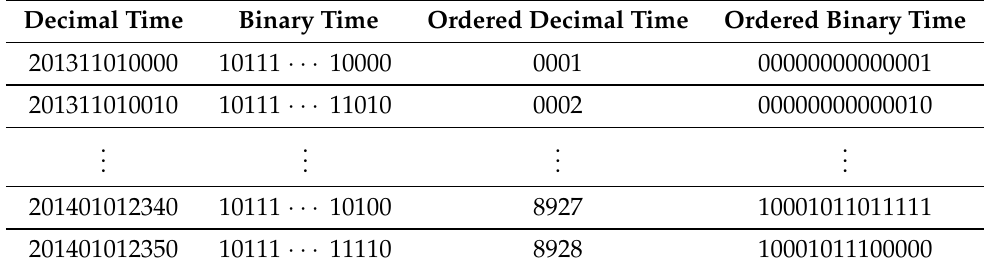
Table 1. Four types of representations of the time